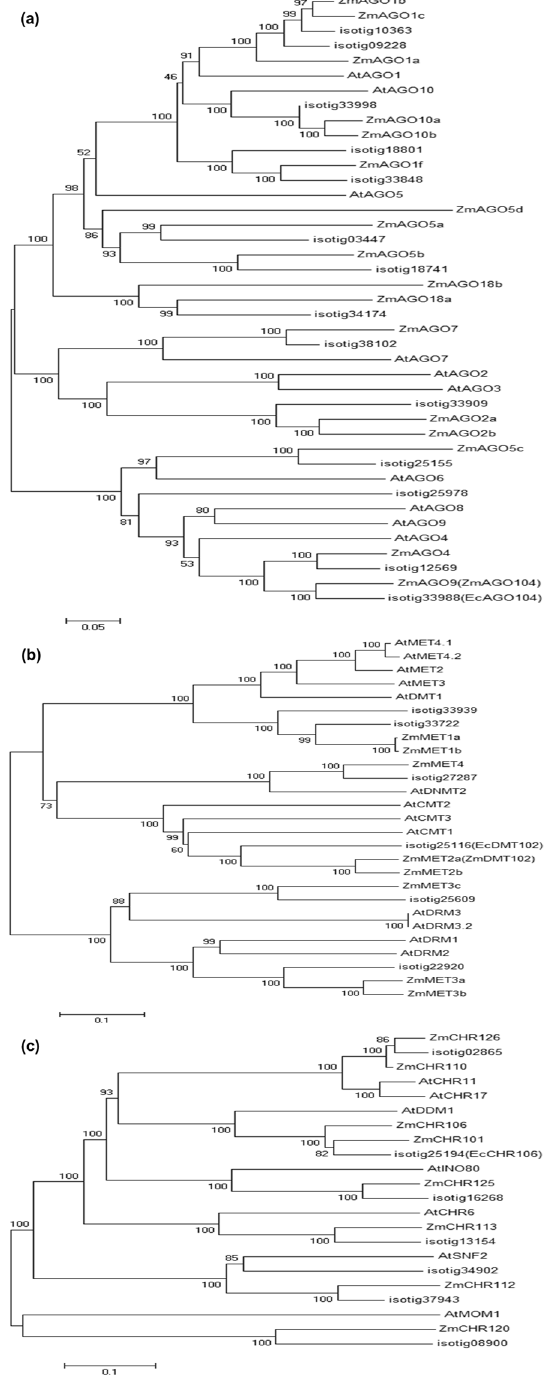
Figure 1. Phylogenetic trees of E . curvula RNA-dependent DNA methylation proteins in A . thaliana and Z . mays . ( a ) AGO, ( b ) DMT, and ( c ) CHR proteins from Arabidopsis and maize were retrieved from the The Arabidopsis Information Resource (TAIR) and the Maize Genetic and Genomic Database (MaizeGDB), respectively. The amino acid sequences of E . curvula were obtained from our floral reference transcriptomes. The unrooted neighbor-joining tree was constructed using MEGA